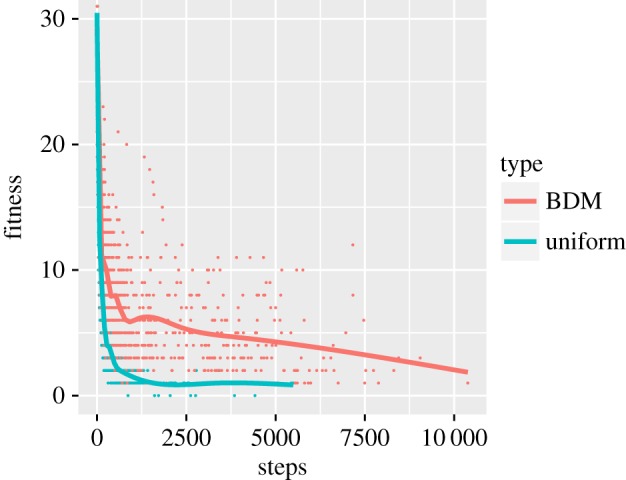
Fitness graph for random 8 × 8 matrices with 3-bit shifts (mutations). Evolution convergence is reached at a fitness of 0. The curves are polynomial approximations computed for visual aid purposes.